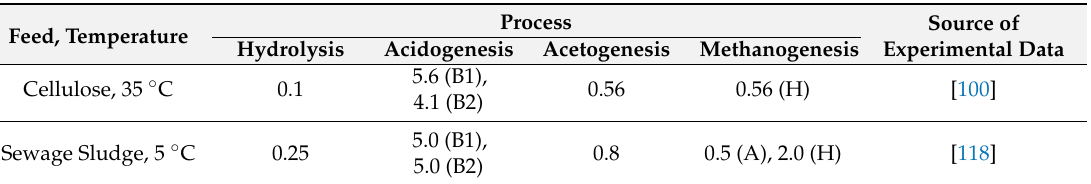
Table 5. The characteristic values of maximum growth rate constants (day 1) of biomass and first-order hydrolysis constants used in METHANE model. [115]. Process Source of Feed, Temperature Experimental Hydrolysis Acidogenesis Acetogenesis Methanogenesis